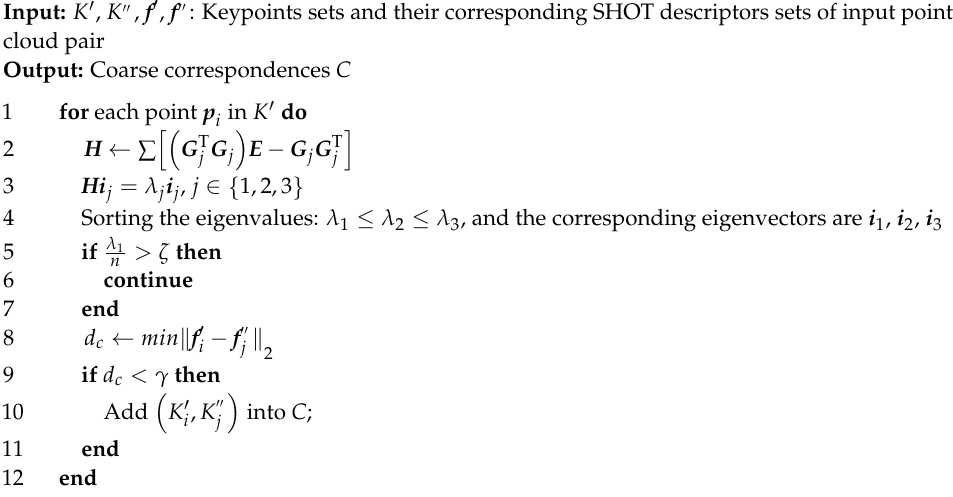
Algorithm 2. Invalid Keypoints Elimination Method